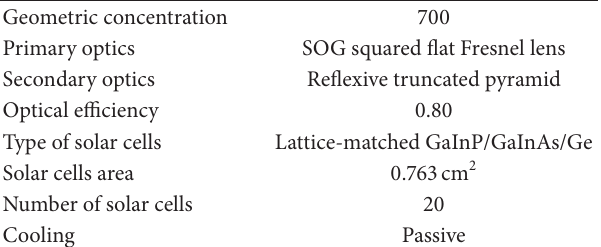
Table 1: Characteristics of the high concentrator photovoltaic module used in the study. Every cell is protected with a bypass diode.